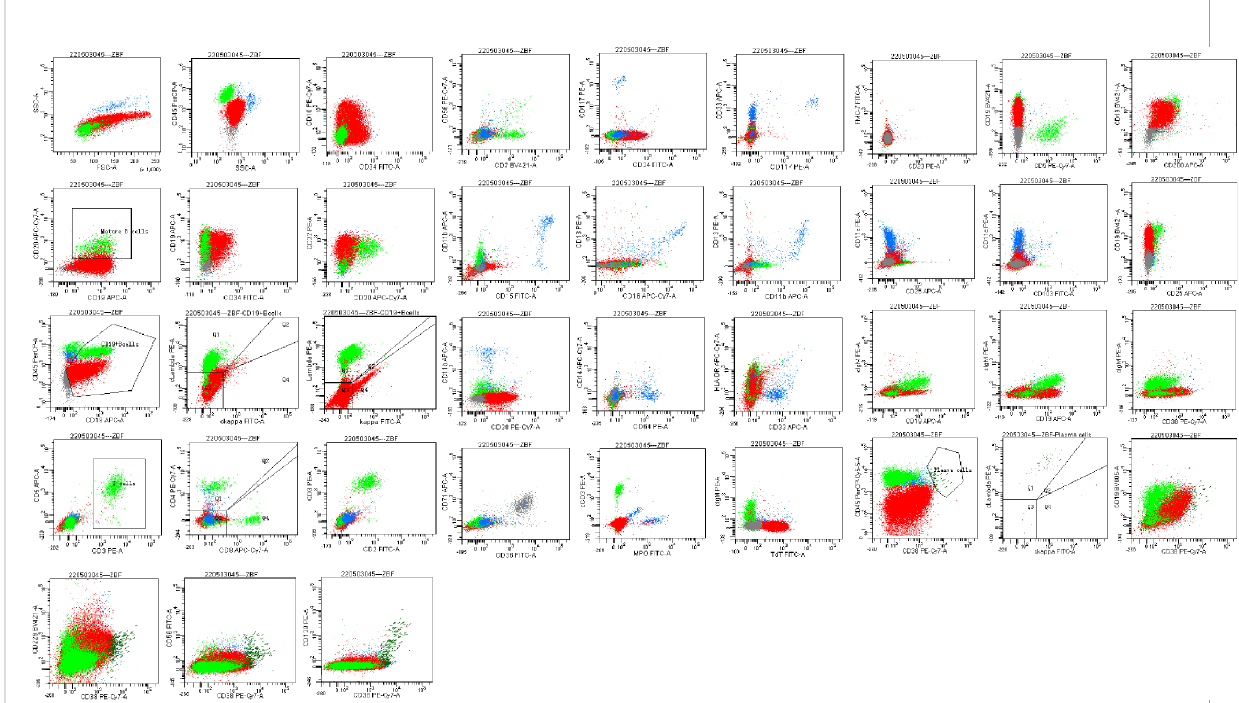
FIGURE 2 Bone marrow fl ow cytometry revealed an abnormal cell population occupying about 82.1% of nuclear cells, expressing CD19, CD22, and TdT. Some cells expressed HLA-DR, CD10, CD34, and CD38, not expressed cIgM, indicating abnormal naive B lymphocytes. Cells with CD45+CD19+ occupying about 8.0% of nuclear cells, expressing HLA-DR, CD19, CD20, CD22, sIgM, cIgM, cLambda, Lambda, suggested aberrant monoclonal B lymphocytes. Cells with CD45dimCD38bright occupied about 0.1% of nuclear cells, expressing CD19, CD38, CD56, CD138, CD229, cLambda, suggested aberrant monoclonal plasma